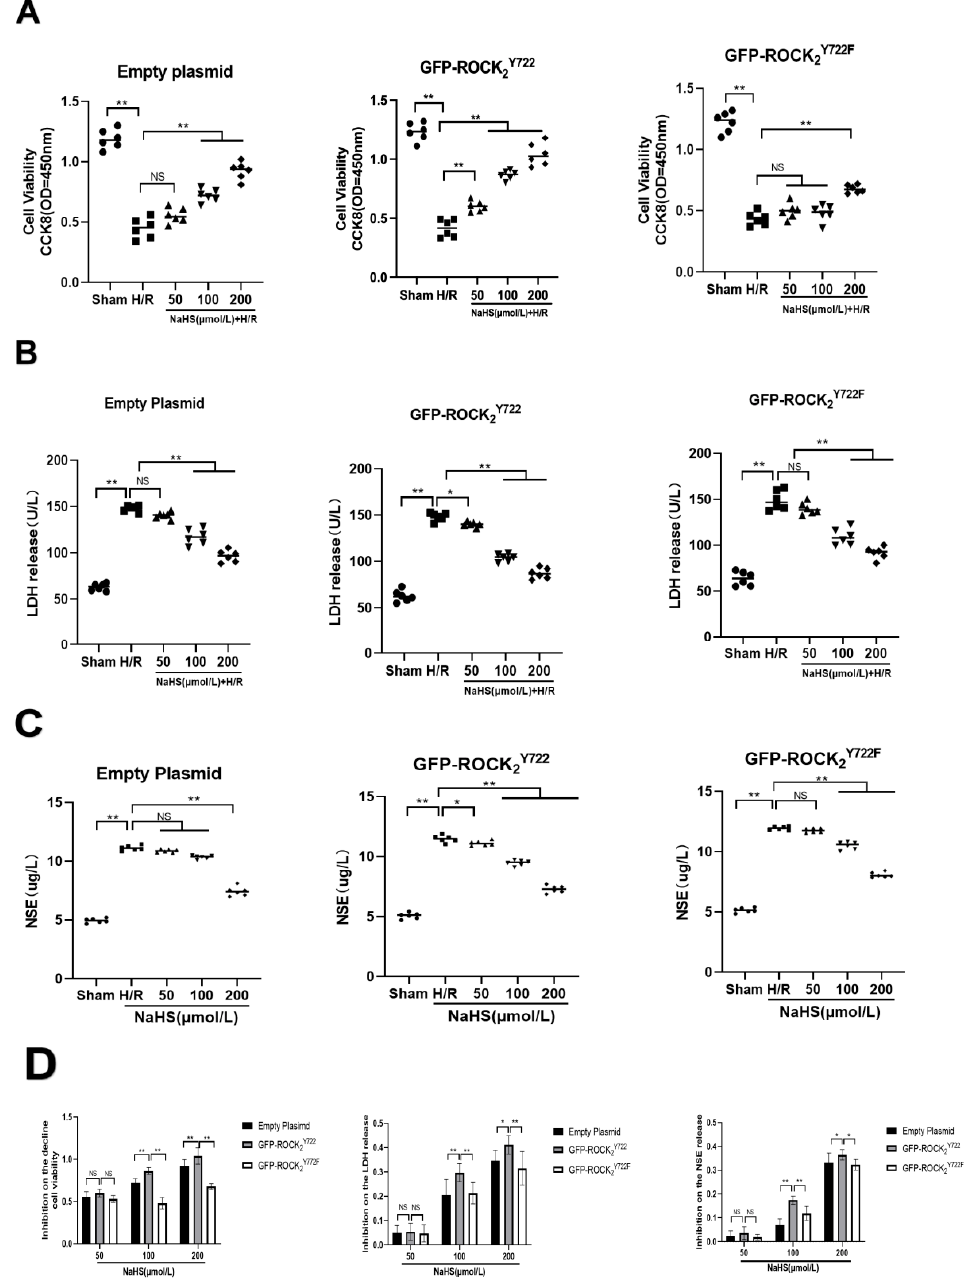
Figure 5. ROCK 2 Tyr722-mediated protection of NaHS on H/R injury in transfected RHNs (mean ± SEM, n = 6). ( A ) Cell viability. ( B ) Release of LDH. ( C ) Release of NSE. * p < 0.05, ** p < 0.01 vs. H/R group. ( D ) Inhibitory effects on the decreased cell viability and released LDH and NSE. * p < 0.05, ** p < 0.01 vs. GFP-ROCK 2Y722 group.